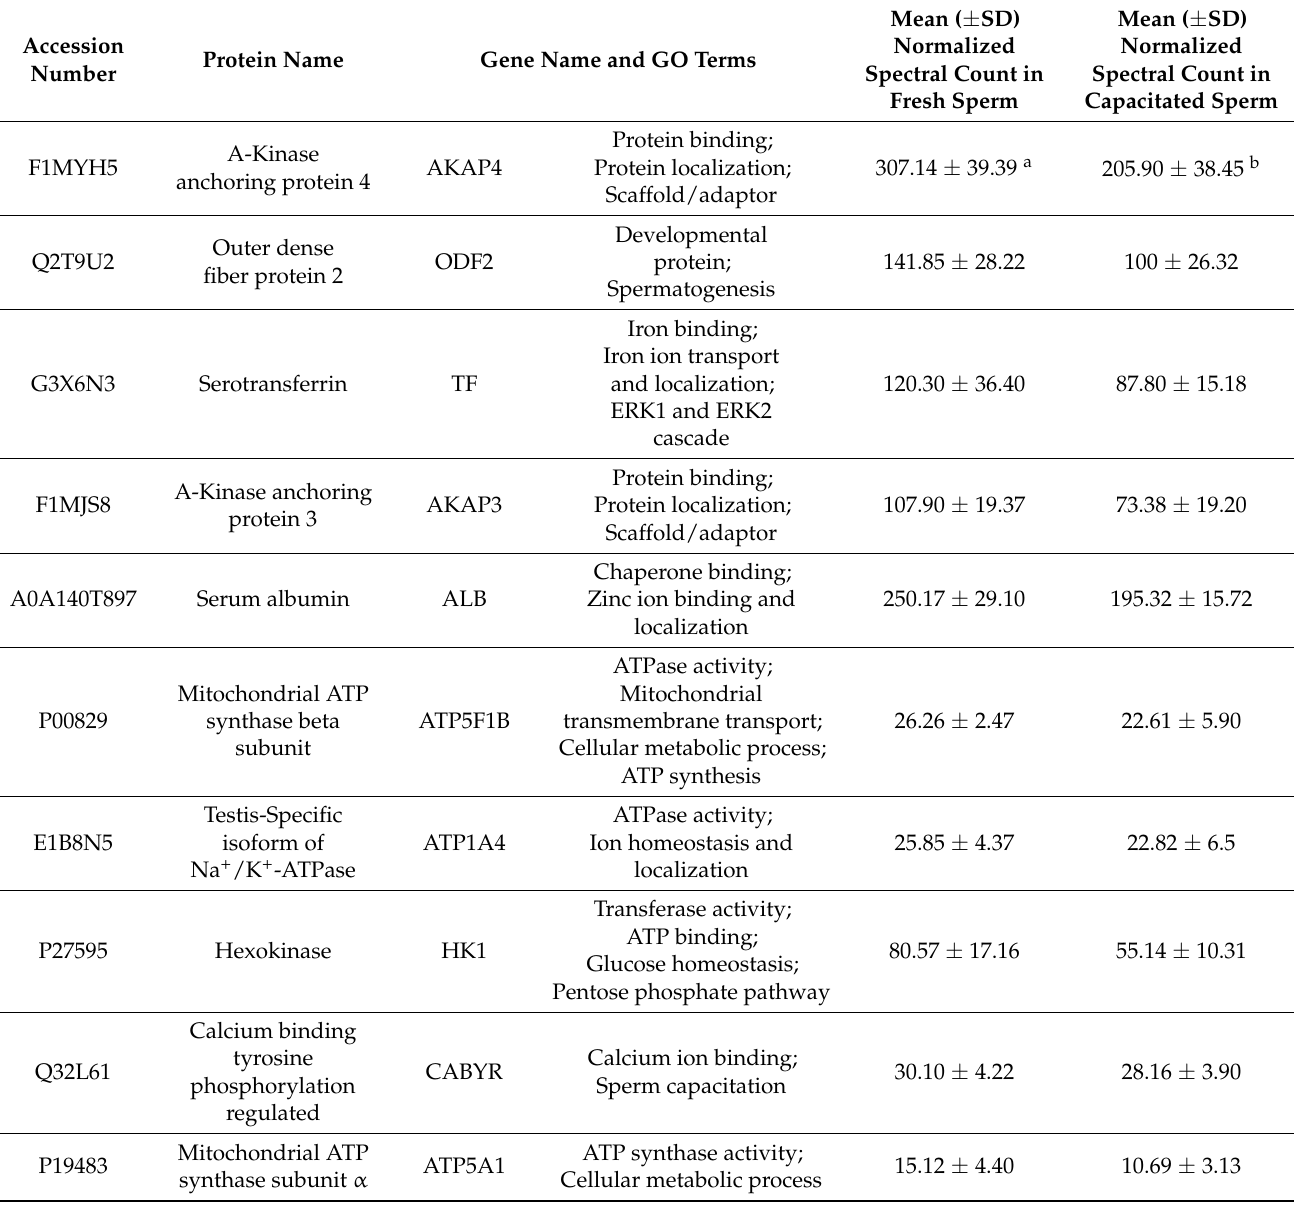
Table 1. Mean normalized spectral counts ( ± SD) as a measure of quantified abundance of proteins interacting with tACE in fresh (0 h control) and capacitated bovine sperm (n = 3) using